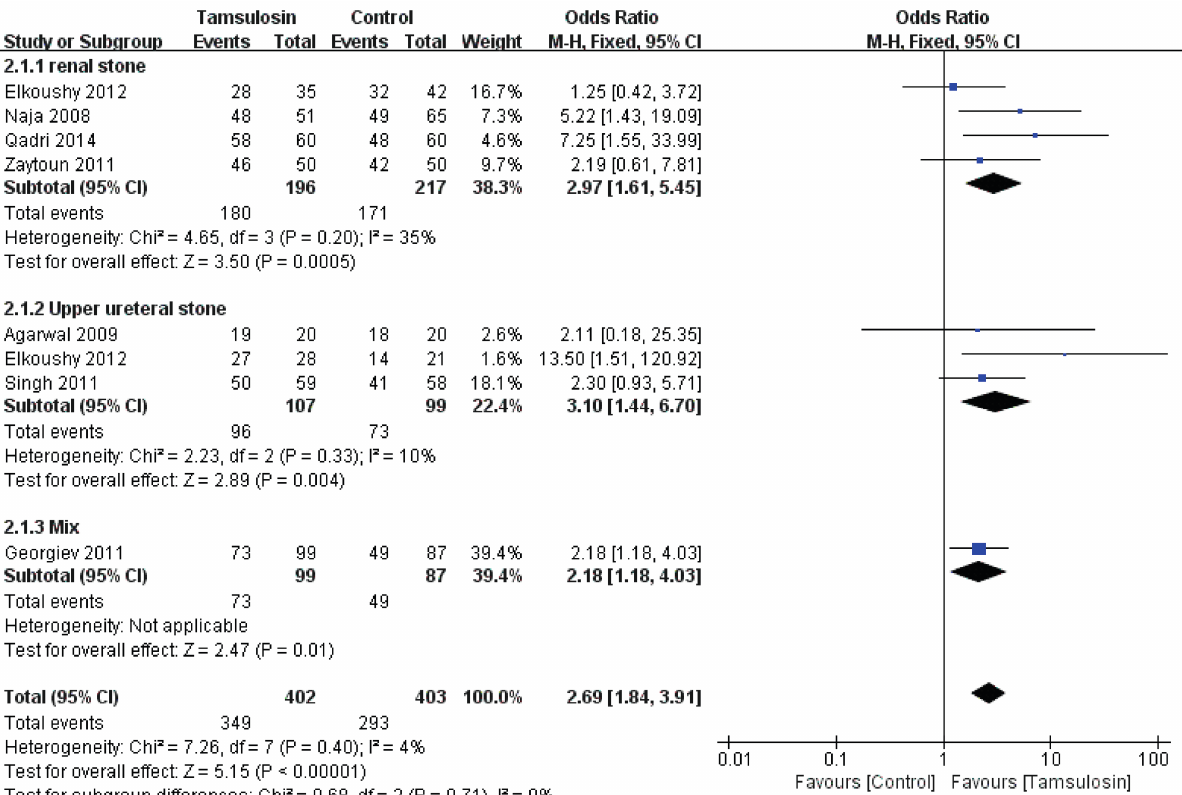
Figure 2 - Forest plots with stone clearance as the outcome according to the location of